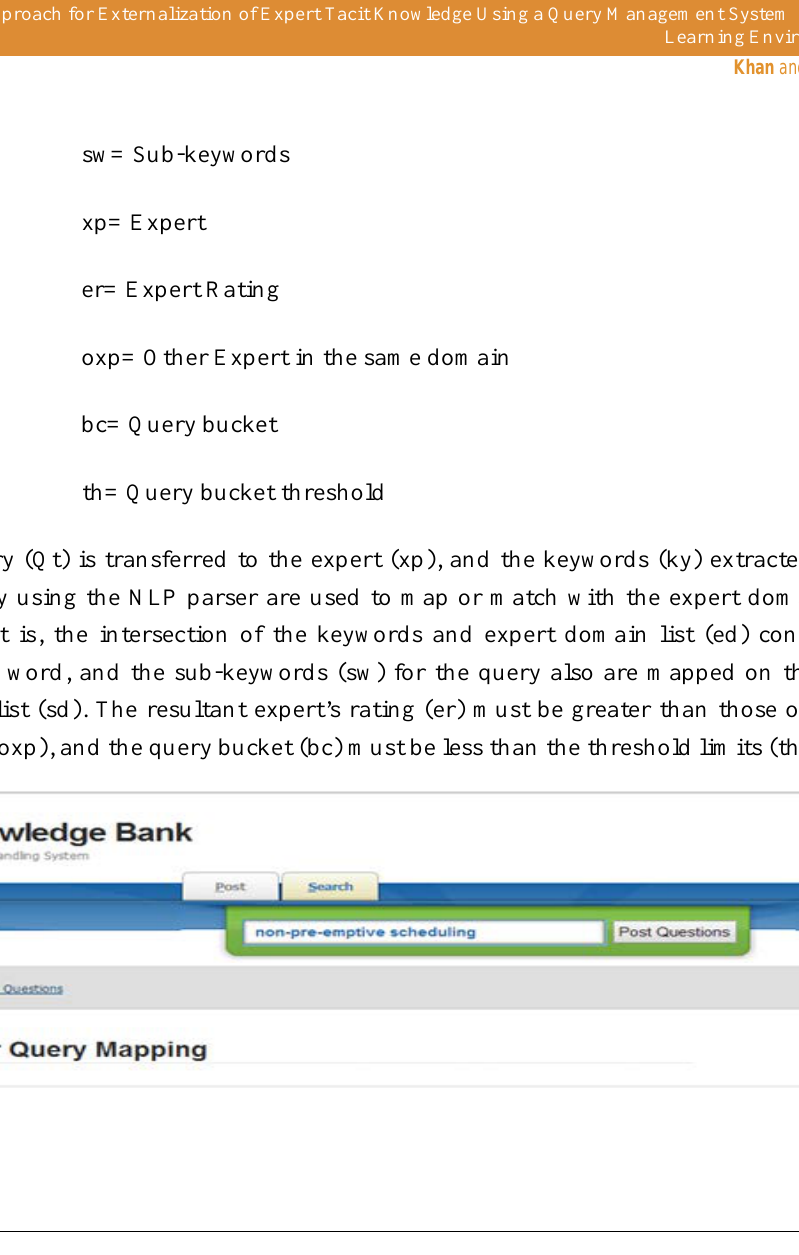
Figure 5 . Query posting screen